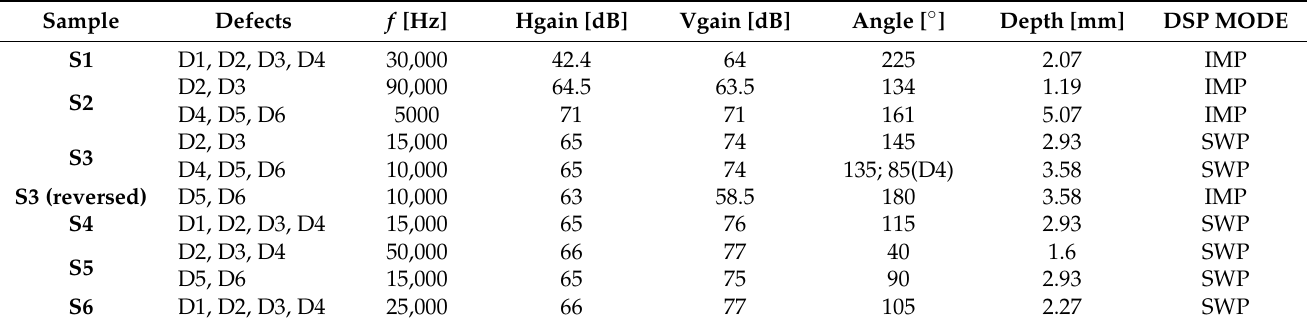
Table 3. Eddy current testing conditions settings.